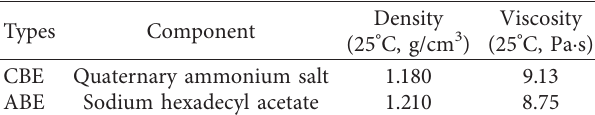
Table 4: Properties of emulsifiers.